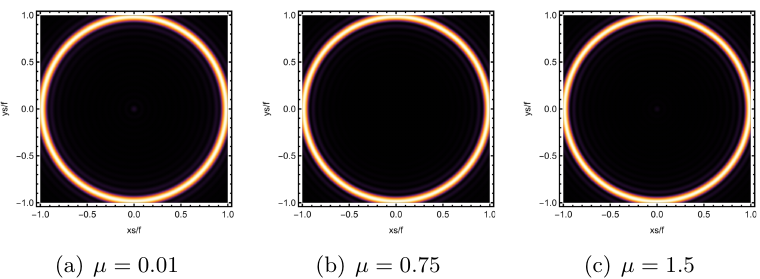
Figure 10 . The variation of the image with the chemical potential at the observation angle θ obs = 0 for the fixed temperature T = 1 /π .